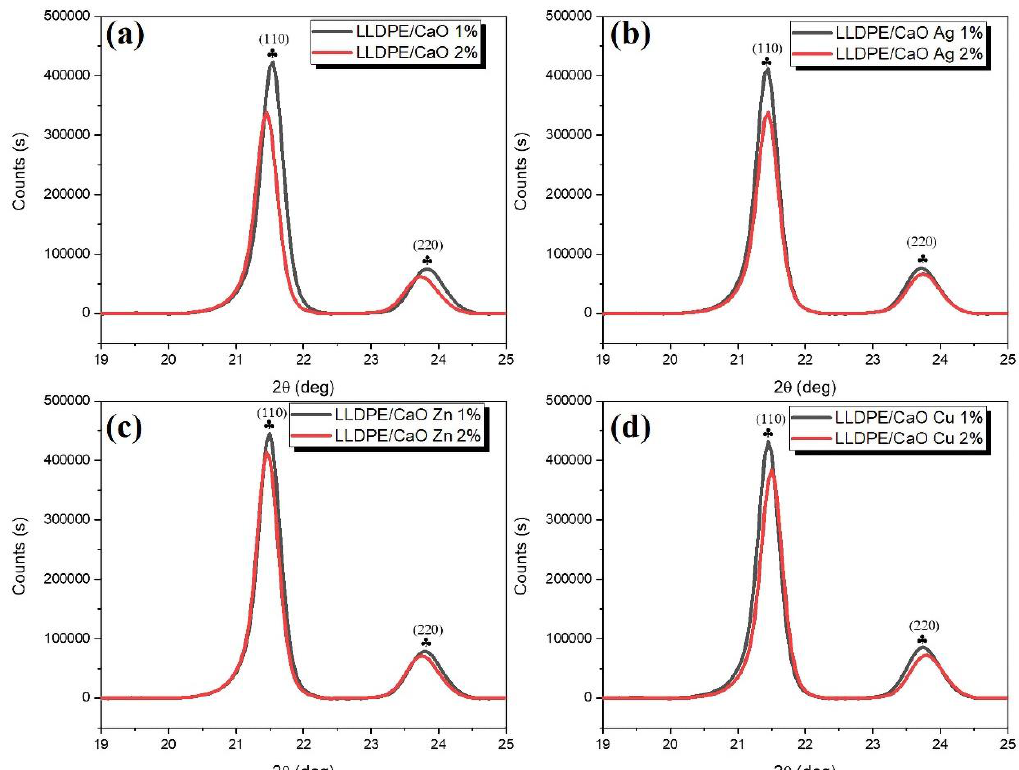
Figure 5. Wide-angle X-ray diffraction (WAXRD) pattern (19 – 25 deg) of ( a ) LLDPE/CaO, ( b ) LLDPE/CaO Ag, ( c ) LLDPE/CaO Zn, and ( d ) LLDPE/CaO Cu.